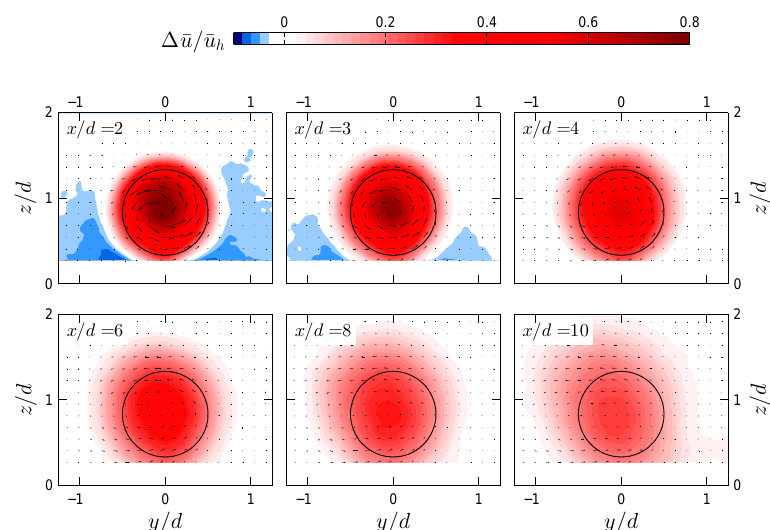
Figure 4. Contours of the normalized velocity deficit ∆ ¯ u h / ¯ u h in yz planes at different downstream locations for the miniature turbine operating at λ = λ o . The vector field represents the in-plane velocity components. The black circles show the frontal area of the wind turbine.